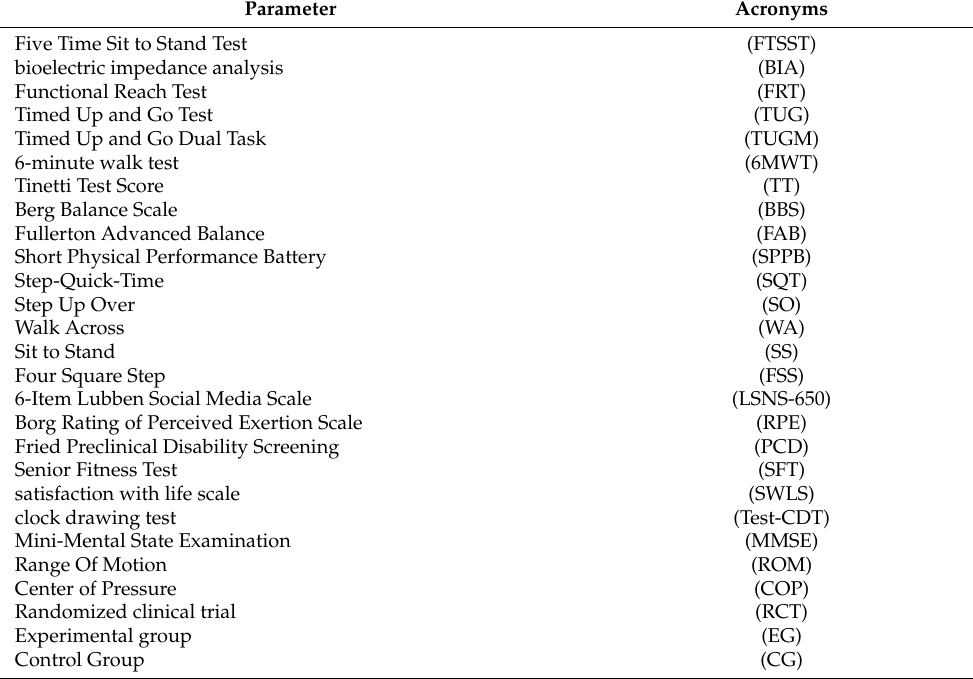
Table 1. Main acronyms